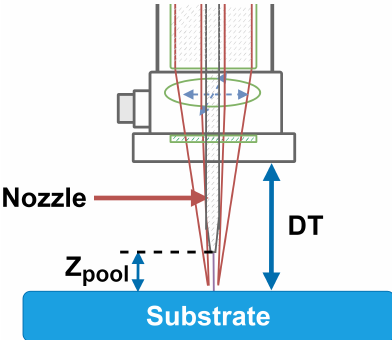
Figure 3. Standoff distance set-up.